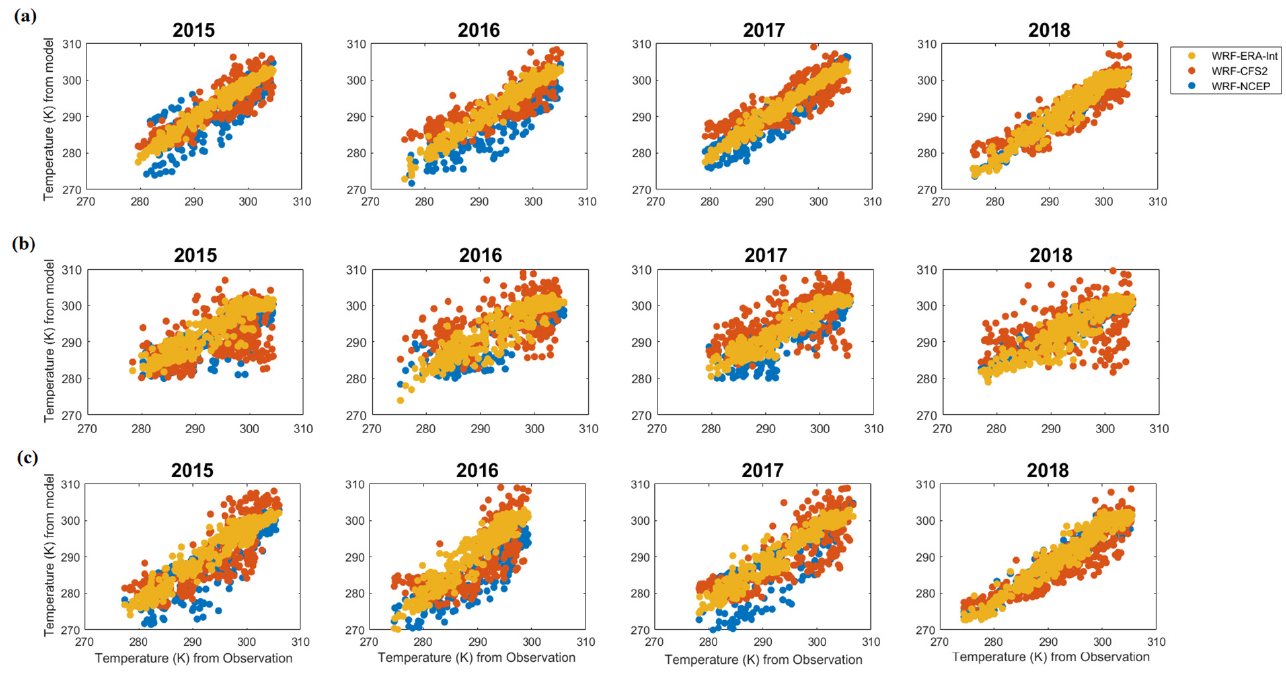
Figure A9. Wind rose diagram on an hourly timescale from the models and observations for the years ( a ) 2017 (top) and ( b ) 2018 (bottom) at Dongsha Dao.